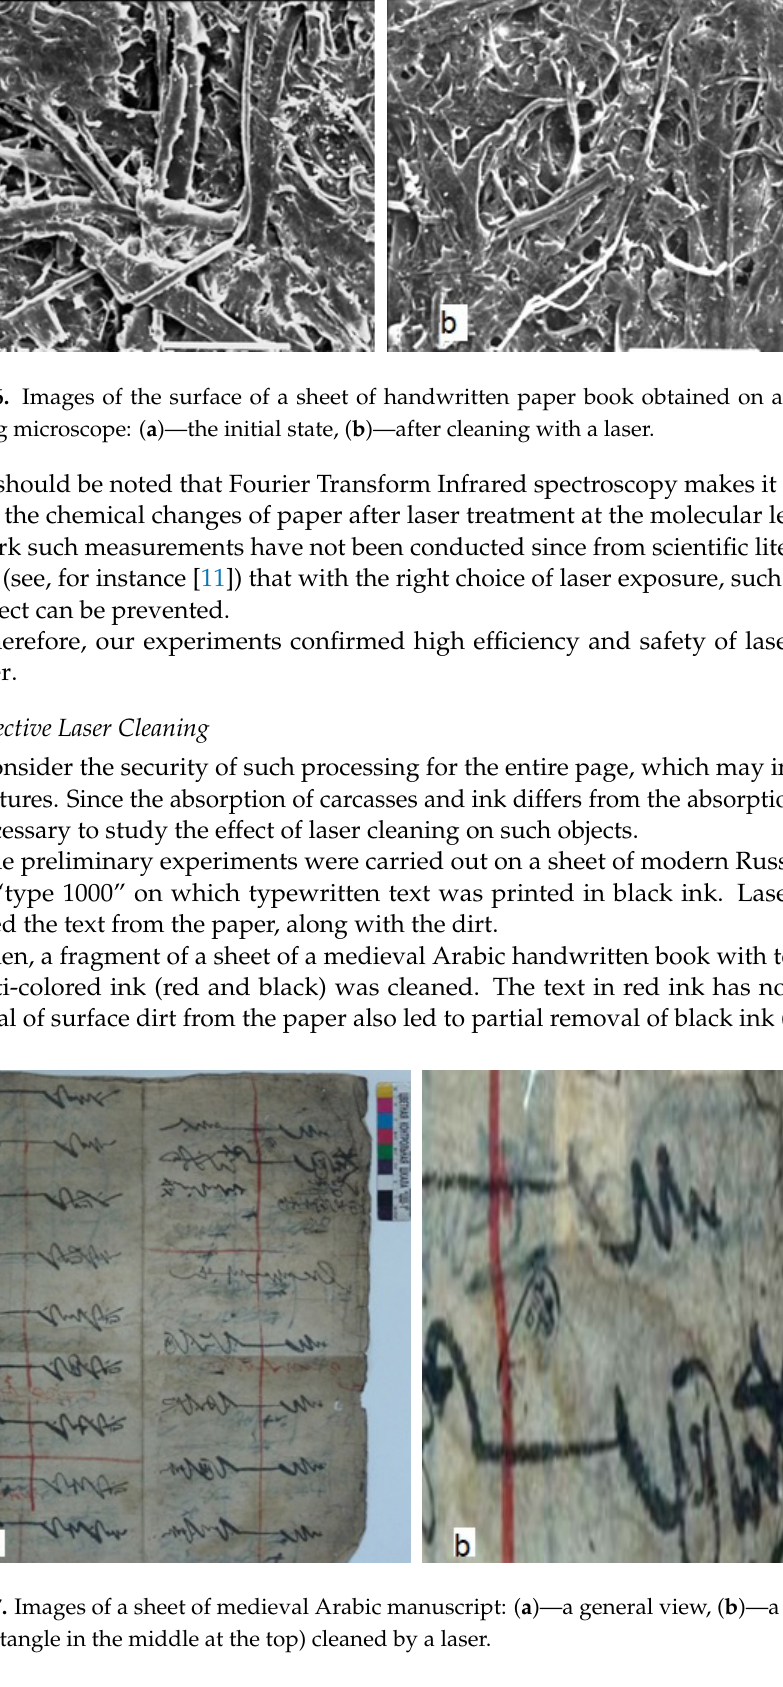
mental area for clearing with a laser; ( c )—the same section of the page after laser processing.